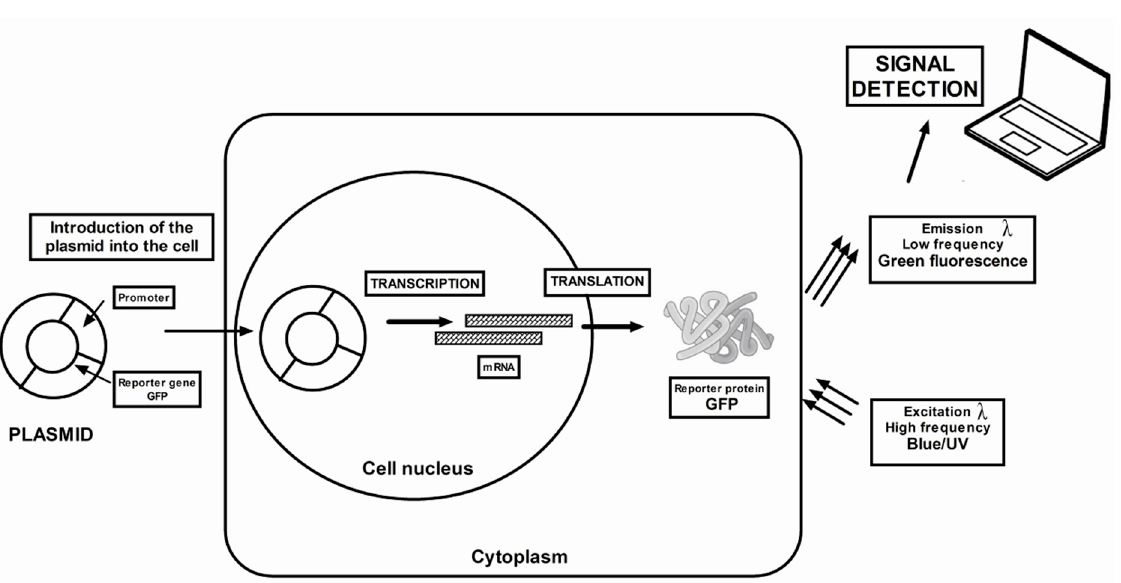
Figure 2. Diagram of the bioluminescence imaging technique using the green fluorescent protein (GFP) reporter gene. The GFP reporter gene is directly attached to the gene of interest to produce gene fusions. The two genes are located under the same promoter elements and are transcribed into a single messenger RNA molecule. The mRNA is then translated into a protein. The protein-GFP hybrid transcribed from the reporter construct possesses a protein linked to GFP. Based on the fluorescence, it can be concluded that the protein is everywhere where green fluorescence occurs.